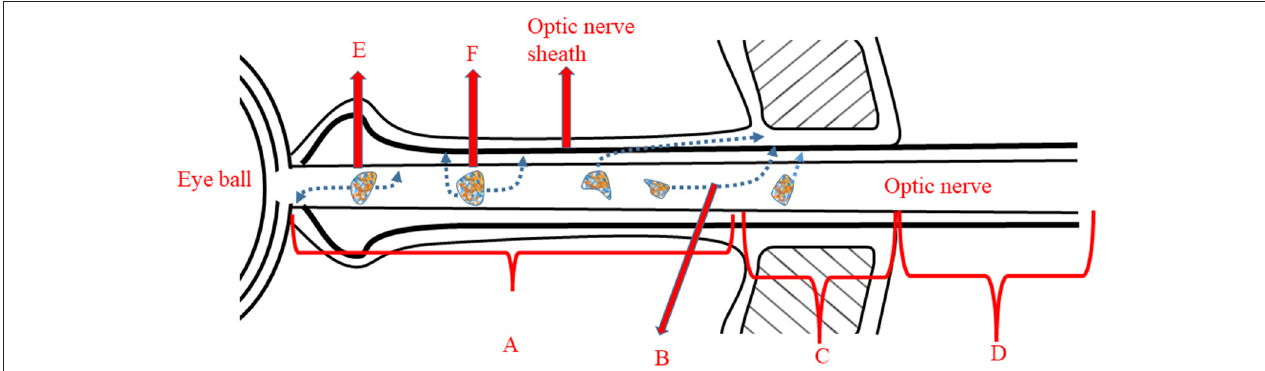
FIGURE 1 | Illustration of origin of pain with eye movement and headache. A, Orbital segment of optic nerve: lesions lying in this segment often trigger pain with eye movement due to proximity to site B; B, The optic nerve sheath attaches to the ocular muscles at this site. Movement of the eye induces the pain experience. C, Intracanalicular portion of the optic nerve. D, Intracranial segment of the optic nerve. E, A mild lesion within the orbital segment which is unlikely to infiltrate to the optic nerve sheath. F, A severe lesion within the orbital segment, which will penetrate the optic nerve sheath and lead to headache.